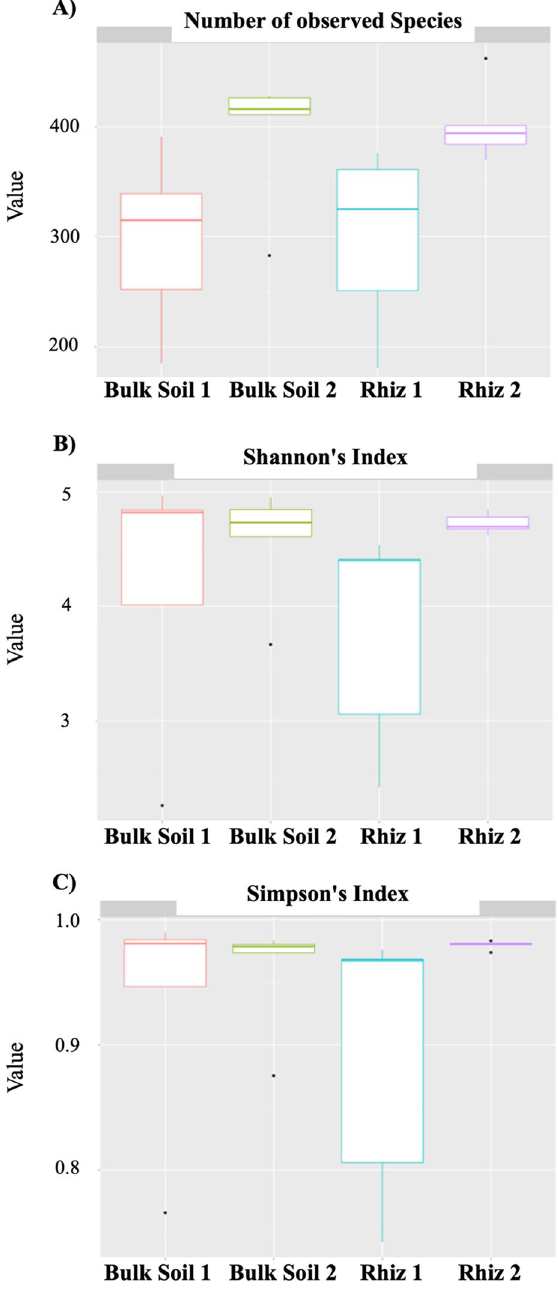
Figure 2. Alpha diversity evaluation: ( A ) Number of bacterial species detected in bulk soil and rhizosphere of V. vinifera at the two sampling times ( B ) Biodiversity (Shannon’s Index) of the microbial community found in bulk soil and the rhizosphere at the two sampling times ( C ) Simpson’s diversity index of the microbial community found in bulk soil and the rhizosphere at the two sampling times. Alpha diversity analysis was performed using R statistical software